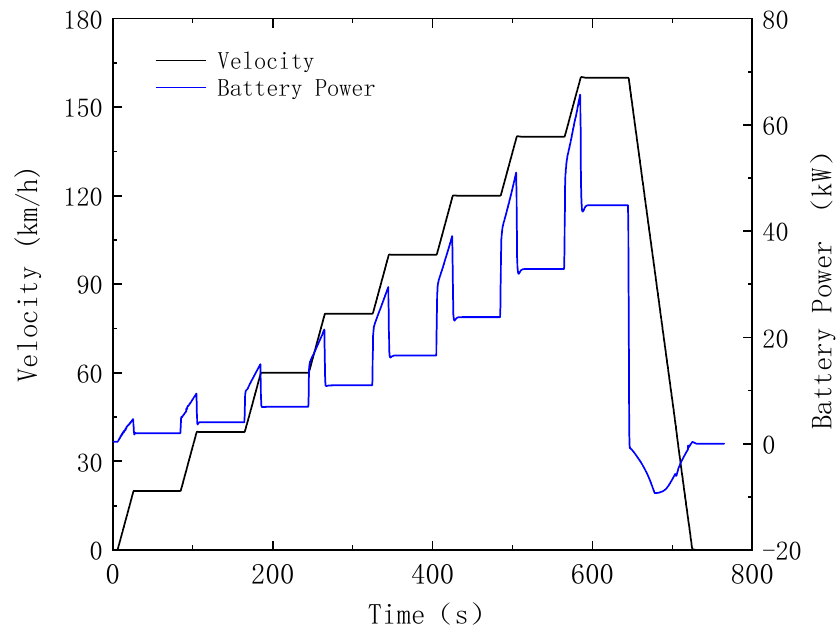
Figure 10. Changes in battery output power of BEV in cruising mode.